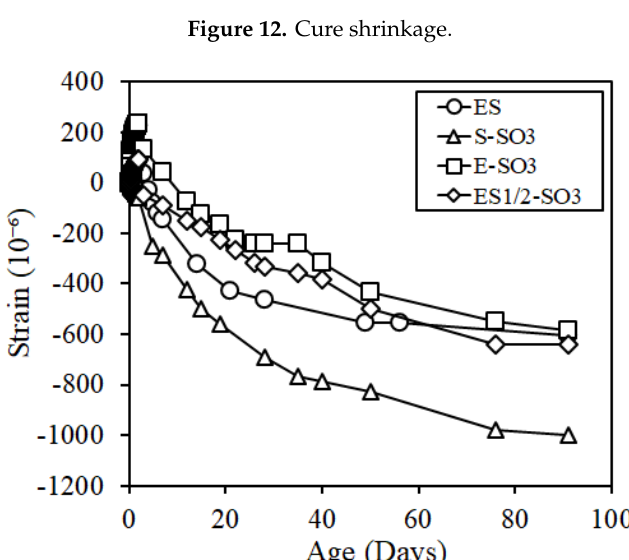
Figure 12. Cure shrinkage.